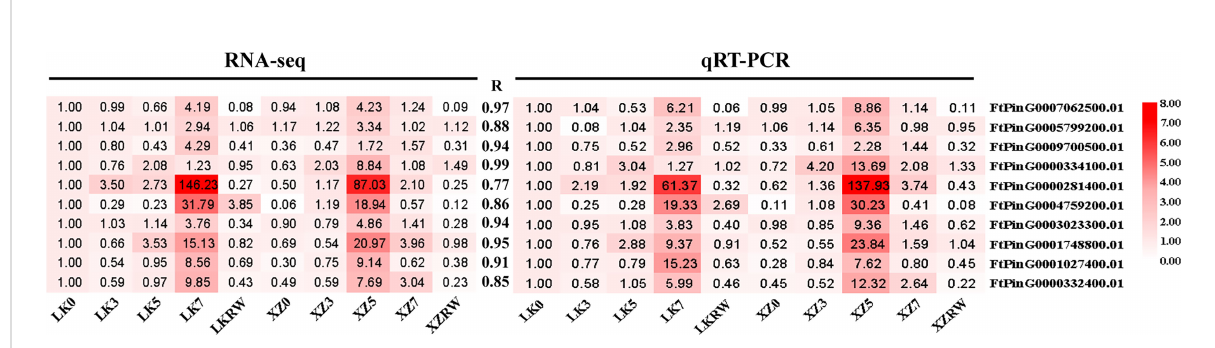
FIGURE 15 Correlation analysis between RNA-seq and qRT-PCR methods. The expression fold change of genes is used to construct the heatmaps. The LK0 is used as a control. The left heatmap represents the RNA-seq, and the right heatmap represents